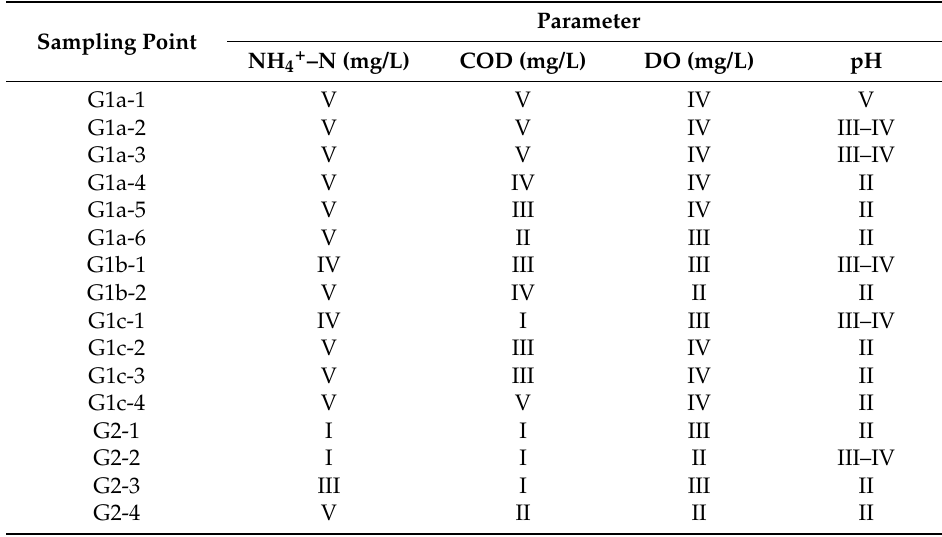
Table 3. Water quality classification of sampling points in the Galing River.